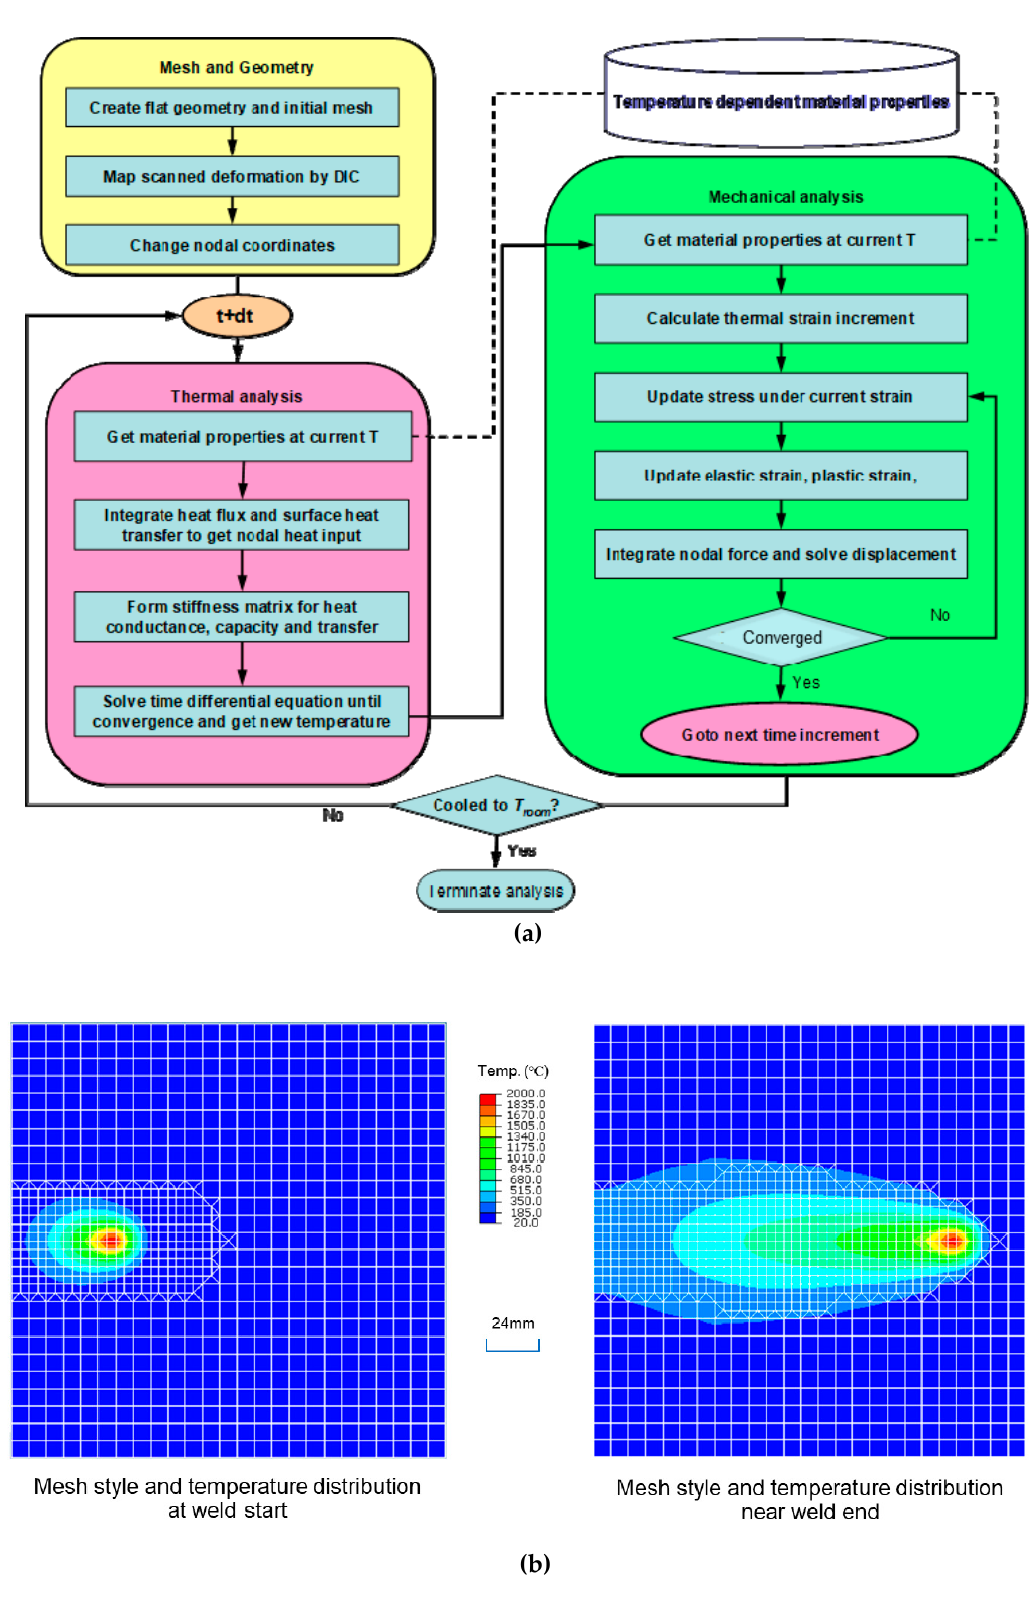
Figure 6. Analysis procedures and dynamic mesh refining scheme in research solver JWRIAN. ( a ) Computation flowchart; ( b ) Dynamic mesh refining scheme.